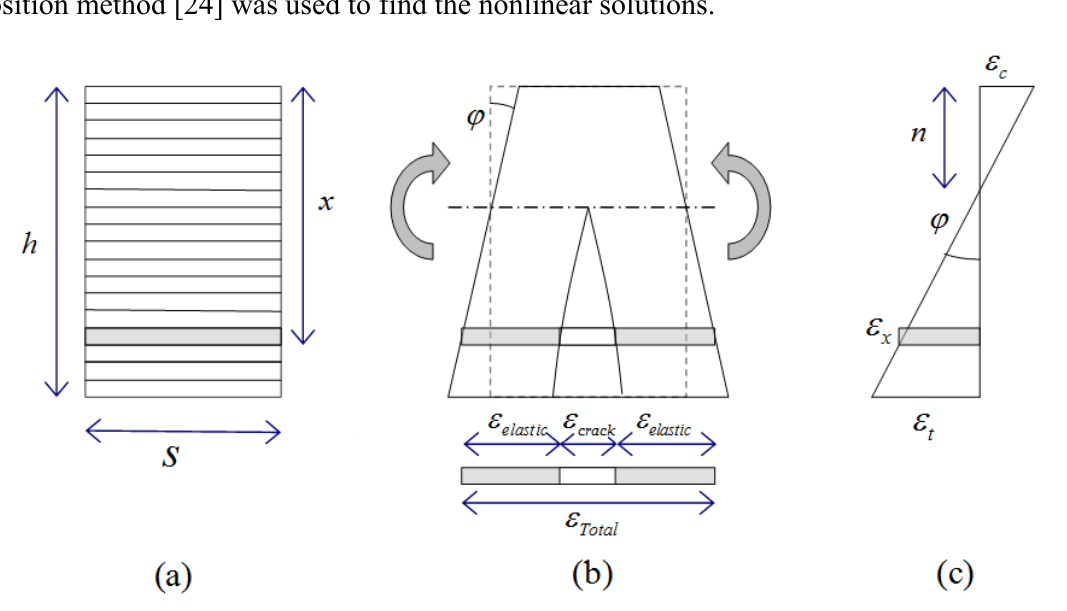
Figure 7. Layered model subjected to flexure: ( a ) un-deformed shape; ( b ) deformed shape; and ( c ) strain distribution over the